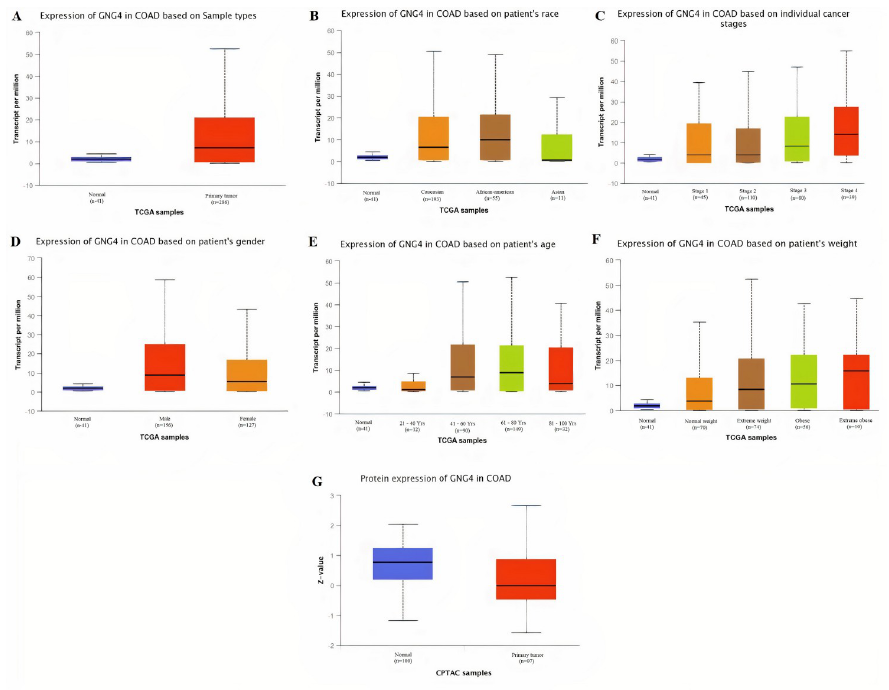
Fig 9. Box plots showing the relative expression levels of GNG4 in normal and COAD samples of different clinicopathological features via UALCAN database. Relative mRNA expression of GNG4: (A) in normal individuals and COAD patients; (B) in normal individuals and COAD patients of different races; (C) in normal individuals and COAD patients of different cancer stages; (D) in normal individuals and COAD patients of different genders; (E) in normal individuals and COAD patients of different age groups; and, (F) in normal individuals and COAD patients of different body weights; (G) Relative protein expression of GNG4 in normal individuals and COAD patients. A p-value of < 0.05 was considered significant. Normal weight = BMI greater than or equal to 18.5 and BMI less than 25, Extereme weight = BMI greater than or equal to 25 and BMI less than 30, Obese = BMI greater than or equal to 30 and BMI less than 40, and Extreme Obese = BMI greater than